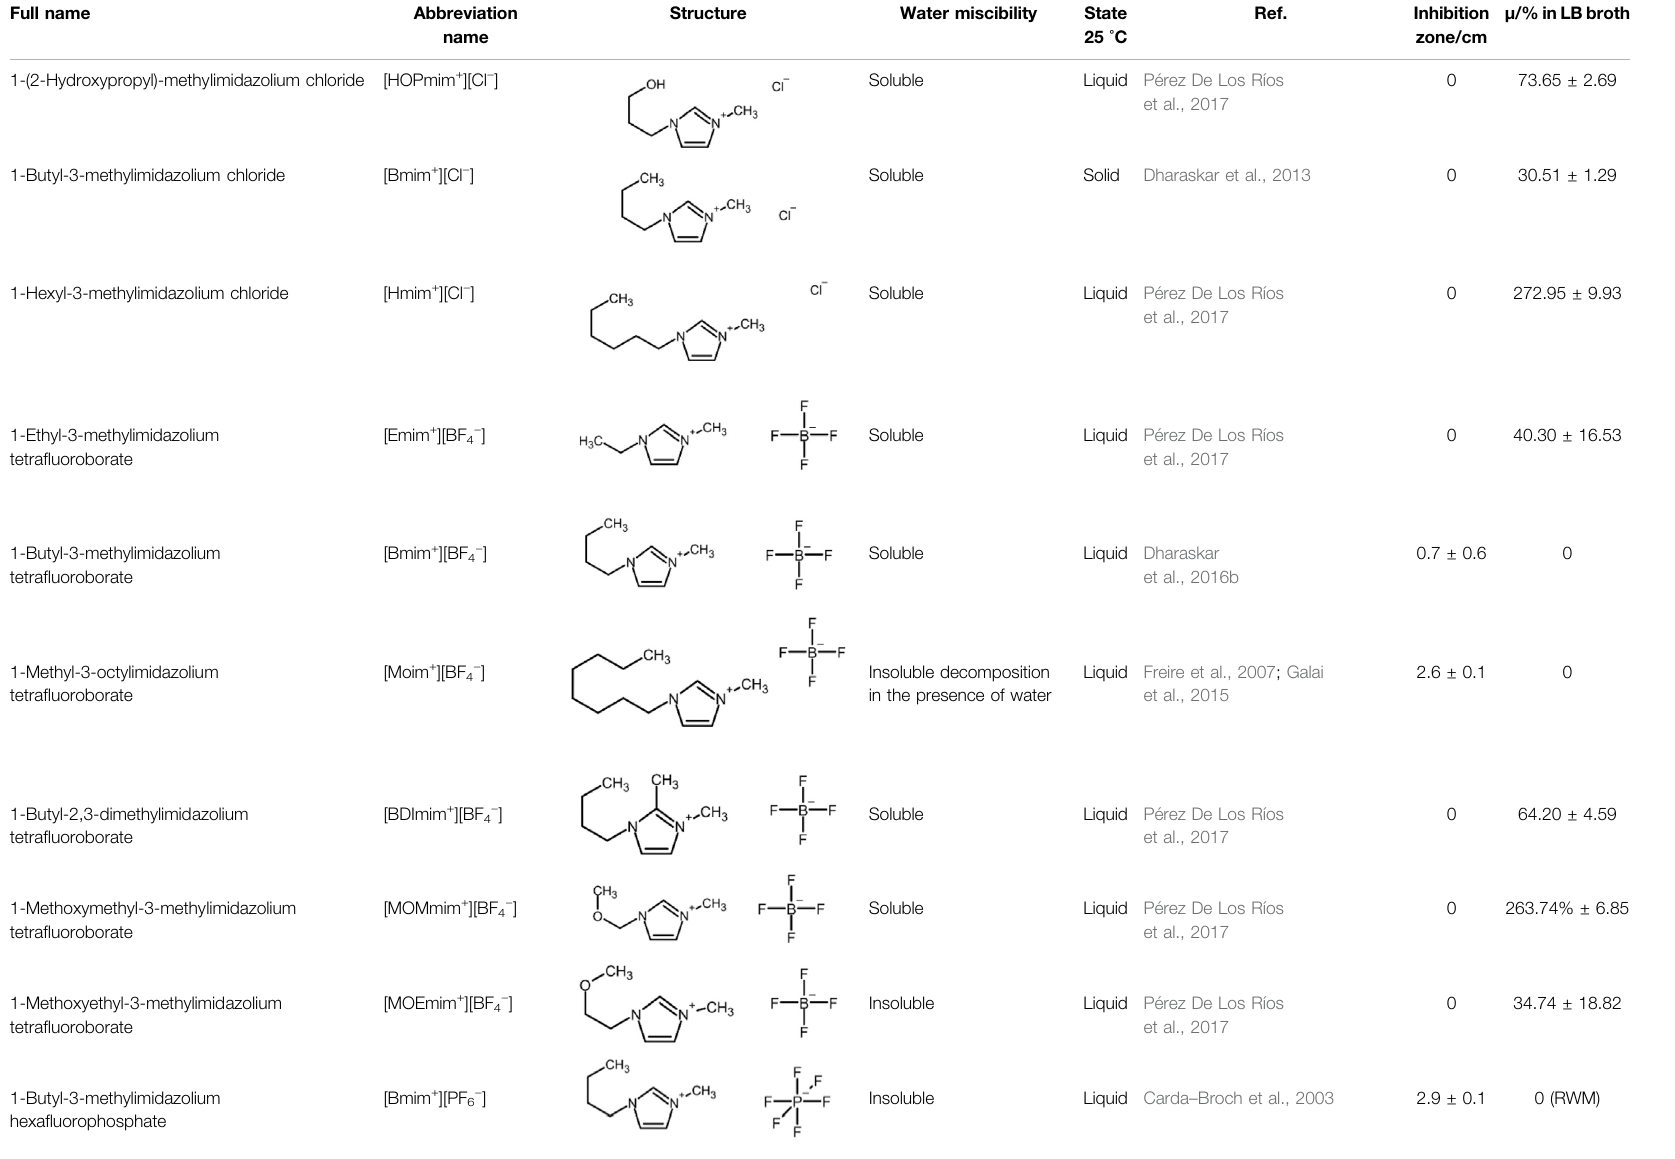
TABLE 1 | Imidazolium-based ionic